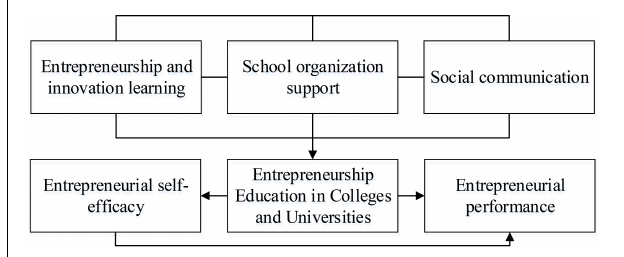
FIGURE 2 | Model construction.